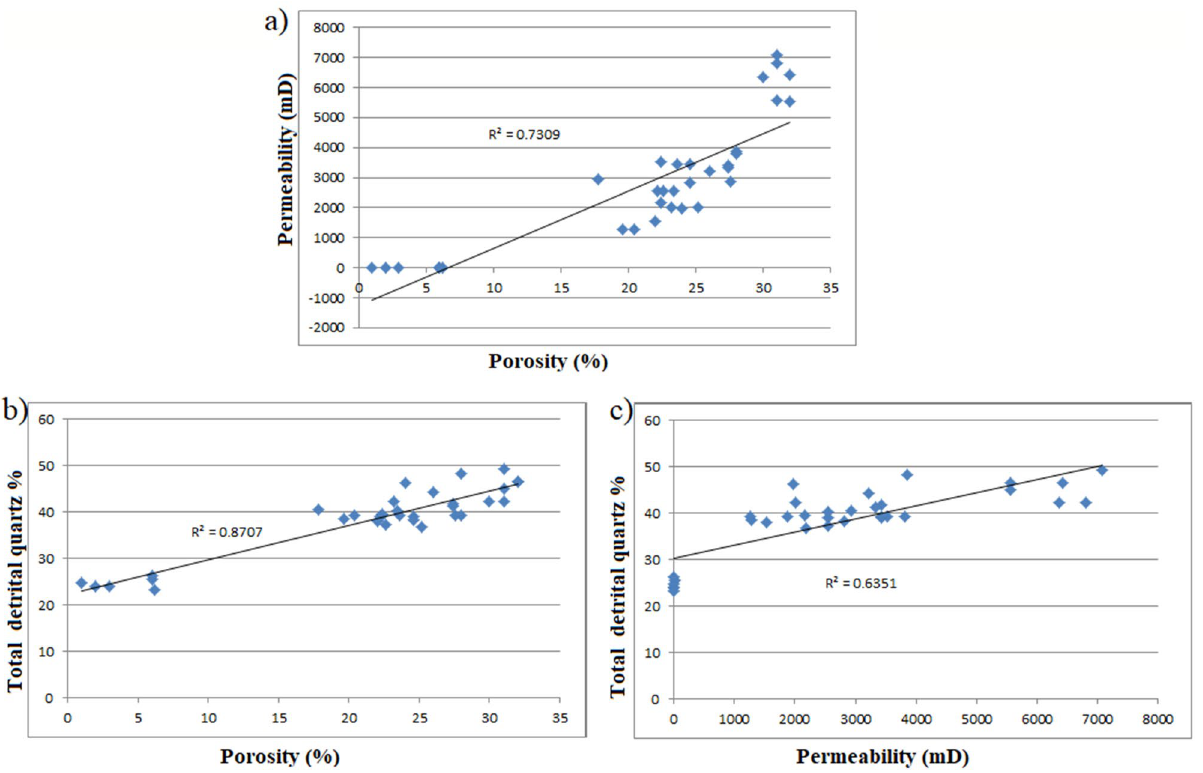
Figure 14. ( a ) Cross plot showing positive correlation between porosity and permeability. ( b and c ) Relationship among detrital quartz content with porosity and permeability respectively. The higher the detrital quartz content, the greater the porosity and